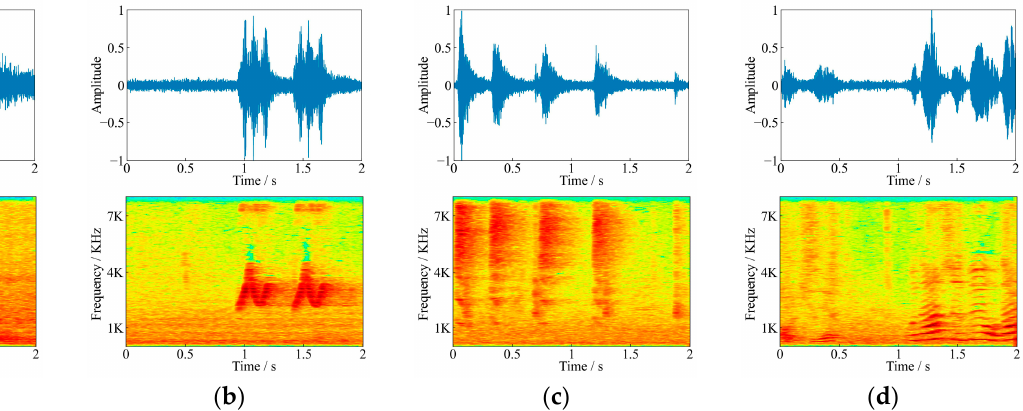
Figure 2. Comparison of waveforms and spectrograms for different kinds of environmental noise, ( a ) vehicle driving, ( b ) whistle, ( c ) bird singing, and ( d ) human voice.